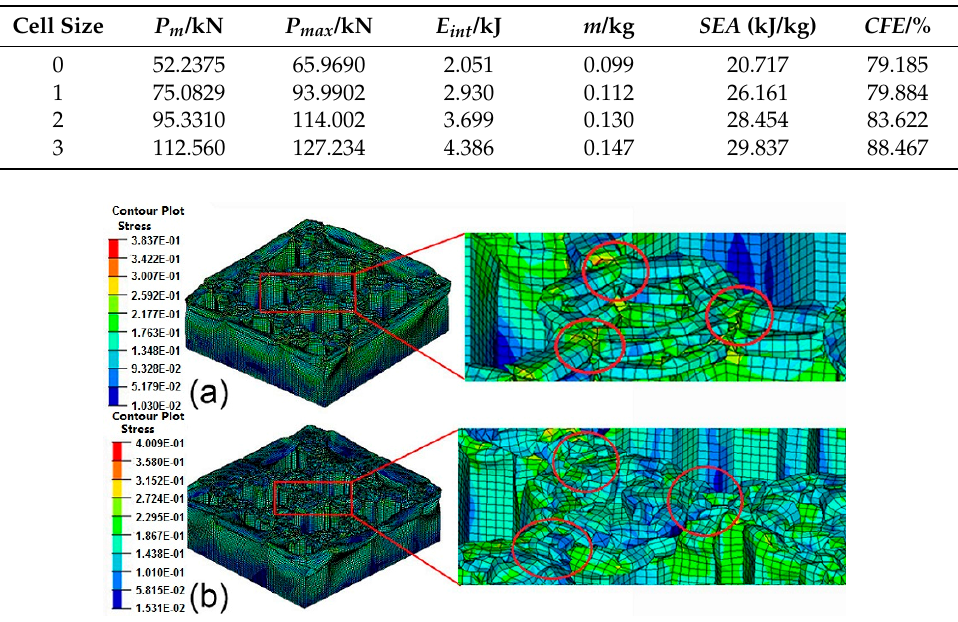
Figure 13. Comparisons of absorbed energy properties of BHS-2 with different filling honeycombs size: ( a ) crushing force versus displacement curves; ( b ) absorbed energy versus displacement curves. Table 3. Energy absorbing behaviors of BHS-2 with different filling cell sizes.